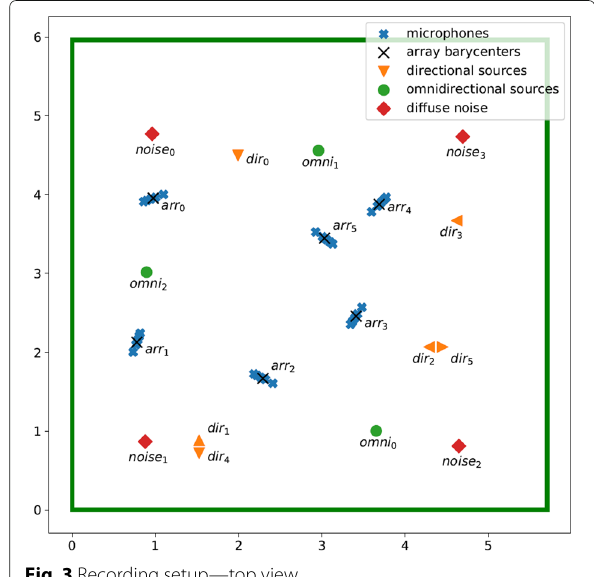
Fig. 3 Recording setup—top view